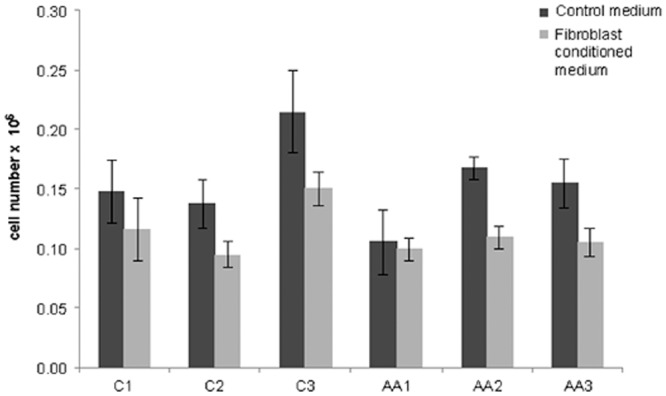
Dermal-fibroblast-derived paracrine signaling inhibits melanocyte proliferation.Melanocyte proliferation varied significantly across melanocyte lineages at baseline (p = 0.0002). Dermal fibroblast-conditioned medium significantly inhibited melanocyte proliferation at 48 hours (p<0.0001), and the degree of inhibition varied significantly between samples (p = 0.05). The data in this graph represents a single experiment in which N = 4; the experiment was reproduced three times. Statistical analysis was based on average values across all six melanocyte lineages rather than individual sample responses to fibroblast-conditioned medium (see Methods).